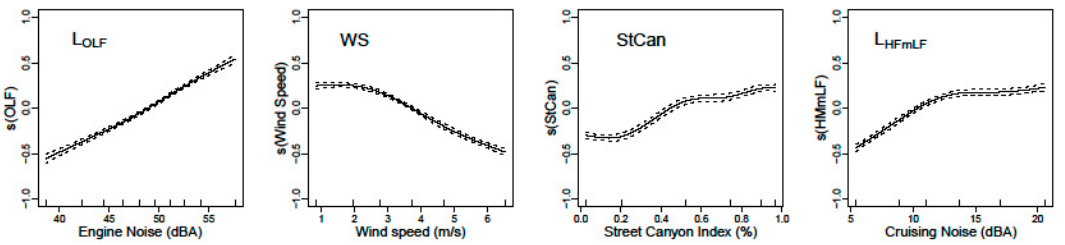
Figure 4. Splines of the BC local generalized additive model (gam). The dashed lines are the confidence interval of the splines.